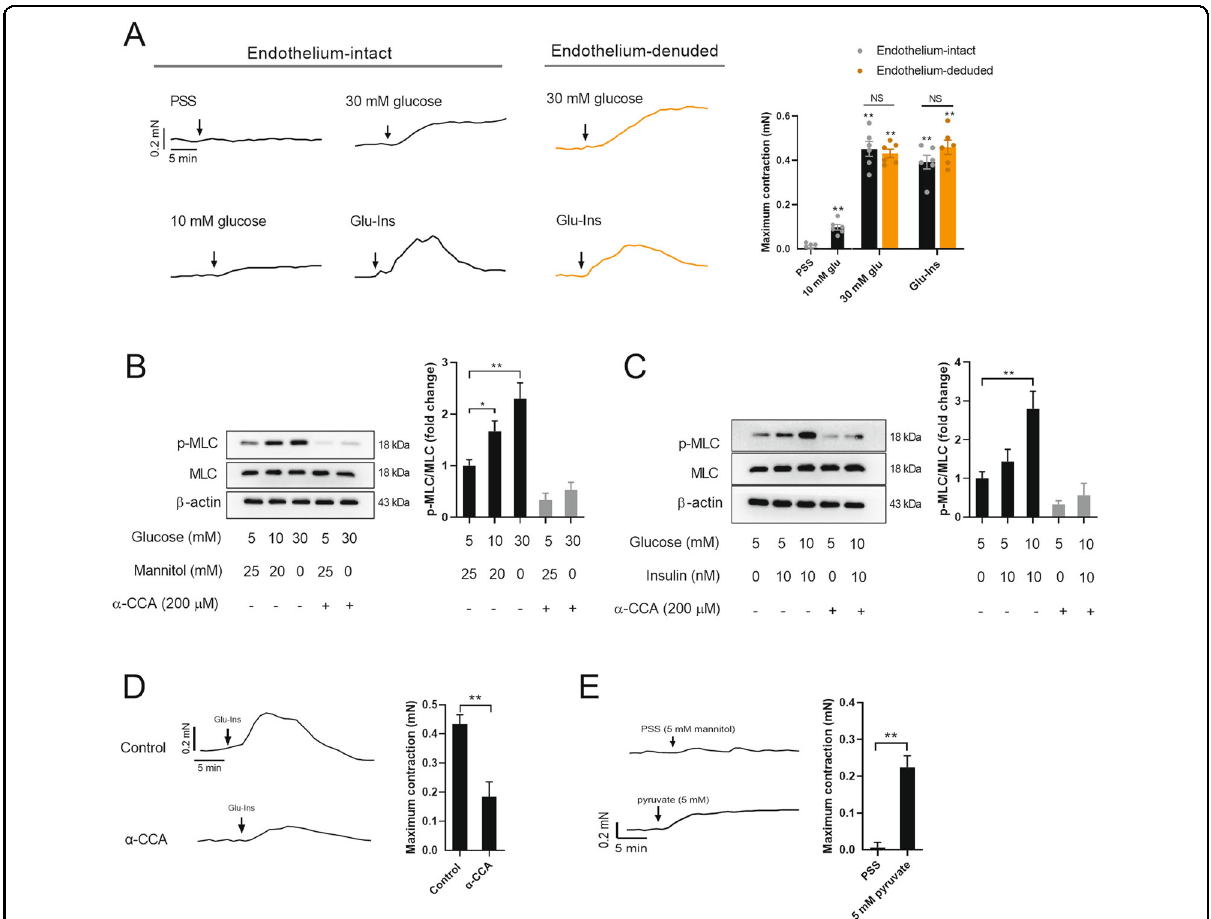
Fig. 2 Glucose-induced vascular constriction is dependent on mitochondrial oxidation in VSMCs. A Glucose (10, 30 mM) and Glu-Ins (10 mM glucose + 10 nM insulin) induced vascular constriction in isolated thoracic aortas with intact endothelium or with denuded endothelium. The aortas were pretreated with PE. Typical tension curves of thoracic aortas were shown in the left, and the quanti fi ed results were shown in right. Osmotic pressure was adjusted with mannitol. * , vs. saline. n = 6. B , C Glucose ( B ) or Glu-Ins ( C ) induced MLC phosphorylation, which was blocked by α -CCA in cultured VSMCs. n = 5. D α -CCA pretreatment blocked the effects of Glu-Ins on induction of vascular constriction in isolated thoracic aortas. The aortas were pretreated with PE. n = 6. E Pyruvate induced vascular constriction in isolated thoracic aortas. The aortas were pretreated with PE. n = 6. Error bars represent SEM. * P < 0.05. ** P <